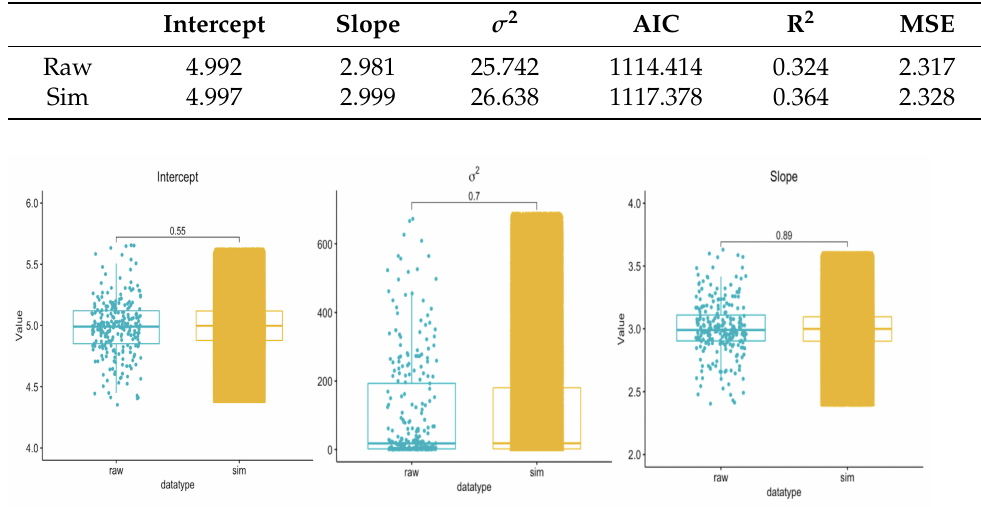
Table 1. The overall mean estimates across tree types, models, and taxa sizes for parameters (intercept, slope, and σ 2 ) as well as fitting measures (AIC, r 2 , and MSE). In the raw row: Trait and tree data were simulated using the true parameters. Sim: Estimates from 100 replicates simulated from the parameter estimates using the raw data across trees, models, taxa size, polytomy type, and polytomy level.